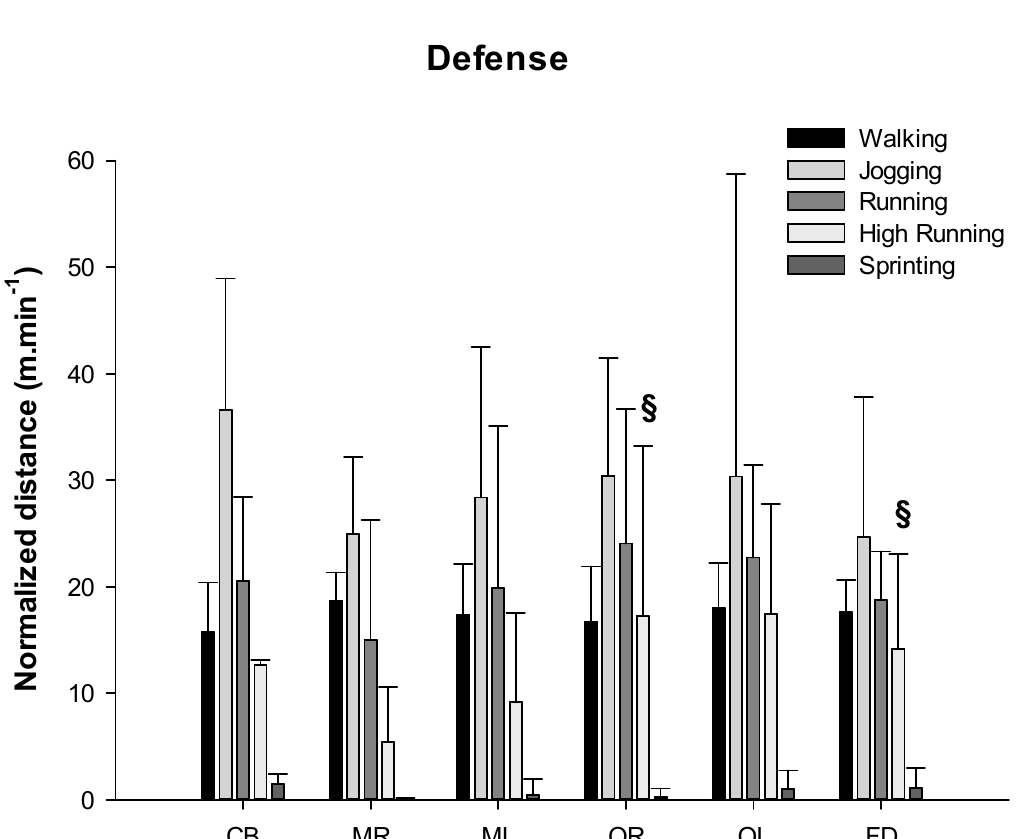
Figure 5. Distance covered in each locomotion category normalized according to the time spent in court in different playing positions during offense. Legend: left wing = LW, left back = LB, center back = CB; line player = LP; right back = RB; right wing = RW.